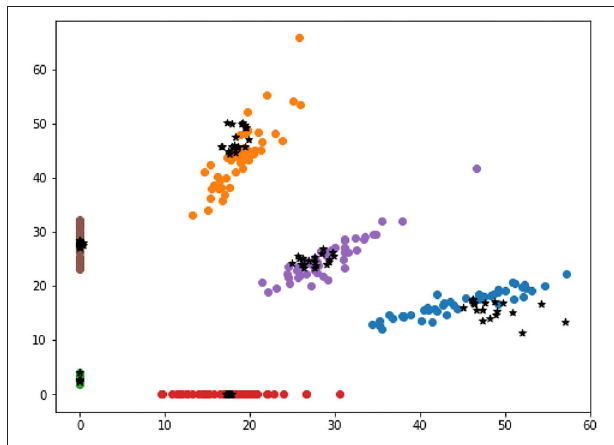
FIGURE 8 | The visualization of low distance-entropy